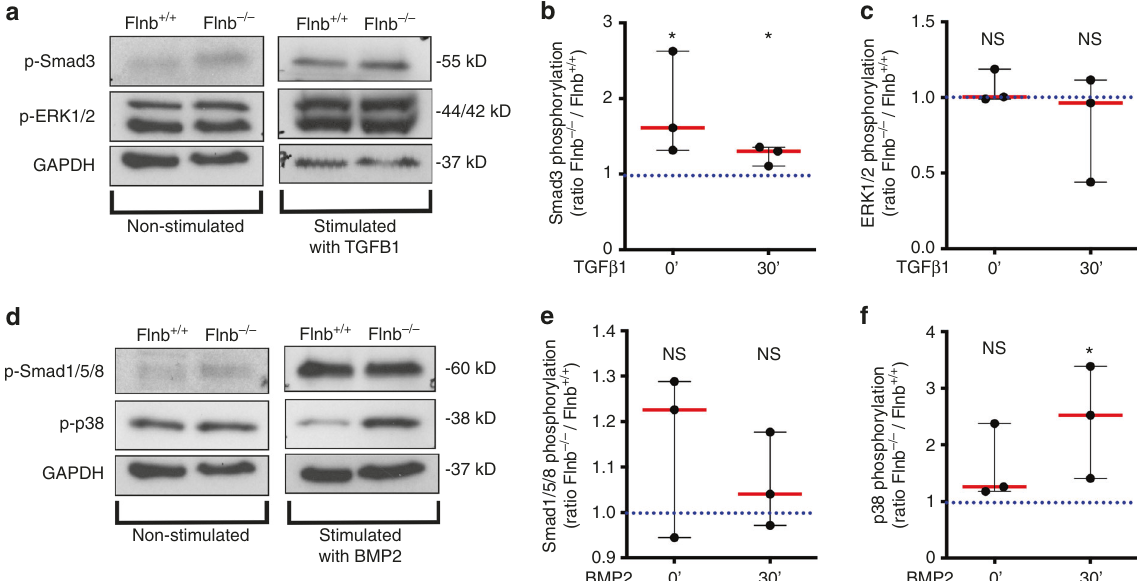
Fig. 2 Isolated primary Flnb − / − AF cells exhibit increased TGF β , ERK, and p38 signaling activation. a Western blots of protein lysates isolated from unstimulated primary AF cells (left column) and stimulated with 5 ng·mL − 1 TGF β -1 ligand for 30 min (right column) probed with antibodies against p-Smad 3, p-ERK1/2, and GAPDH. b Quanti fi cation of TGF β -1-stimulated Western blot normalized against GAPDH levels showing a signi fi cant increase in Smad 3 phosphorylation in both unstimulated and stimulated primary AF cells. c Quanti fi cation of TGF β -1- stimulated Western blot normalized against GAPDH levels showing no signi fi cant increase in ERK1/2 phosphorylation in either unstimulated or stimulated primary AF cells. d Western blots of isolated unstimulated primary AF cells (left column) and stimulated with 5 ng·mL − 1 BMP-2 ligand for 30 min (right column) probed with antibodies against p-Smad 1/5/8, p-p38, and GAPDH. e Quanti fi cation of BMP-2-stimulated Western blot normalized against GAPDH levels showing no signi fi cant increase in Smad 1/5/8 phosphorylation. F Quanti fi cation of BMP-2- stimulated Western blot normalized against GAPDH levels showing a signi fi cant increase in p38 phosphorylation in both unstimulated and stimulated primary AF cells. n = 9 (each data point contains pooled IVD tissue samples from three mice containing six IVDs from each mouse; data points represent biological replicates of Flnb − / − protein lysates each normalized to a Flnb + / + control. The dotted blue line in each graph represents the Flnb + / + protein level, which is set to 1 upon normalization. Signi fi cance is determined by comparing Flnb − / − to Flnb + / + ), NS not signi fi cant, * P < 0.05, ** P < 0.01, *** P <